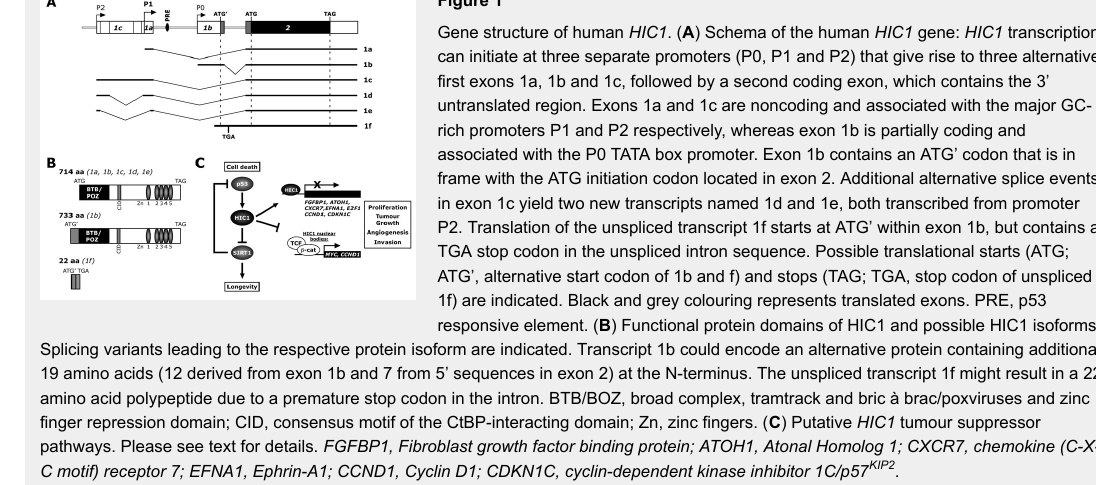
Gene structure of human HIC1 . ( A ) Schema of the human HIC1 gene: HIC1 transcription can initiate at three separate promoters (P0, P1 and P2) that give rise to three alternative